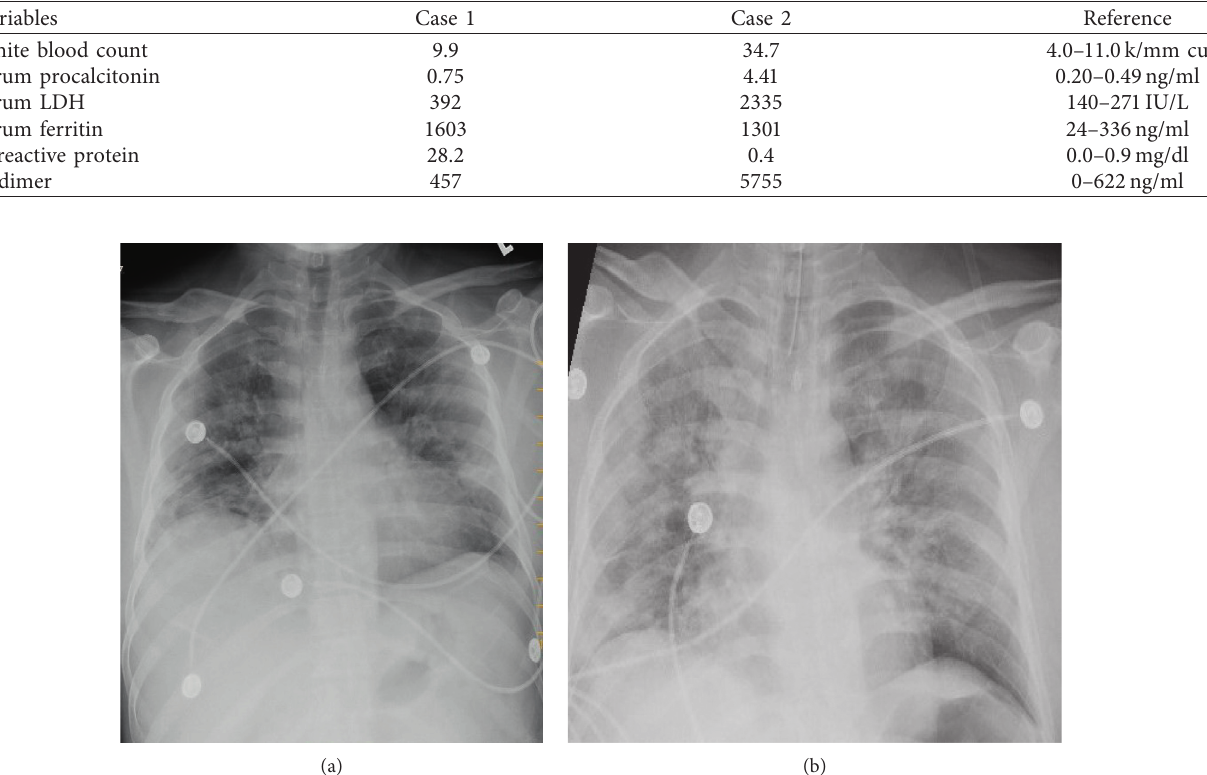
Figure 1: (a) Multifocal interstitial opacities throughout the lung parenchyma bilaterally with elevated hemidiaphragm, discoid atelectasis, and volume loss noted in the right lower lobe. (b) Diffuse interstitial opacities that have increased as compared with the previous exam with endotracheal tube approximately 4cm from